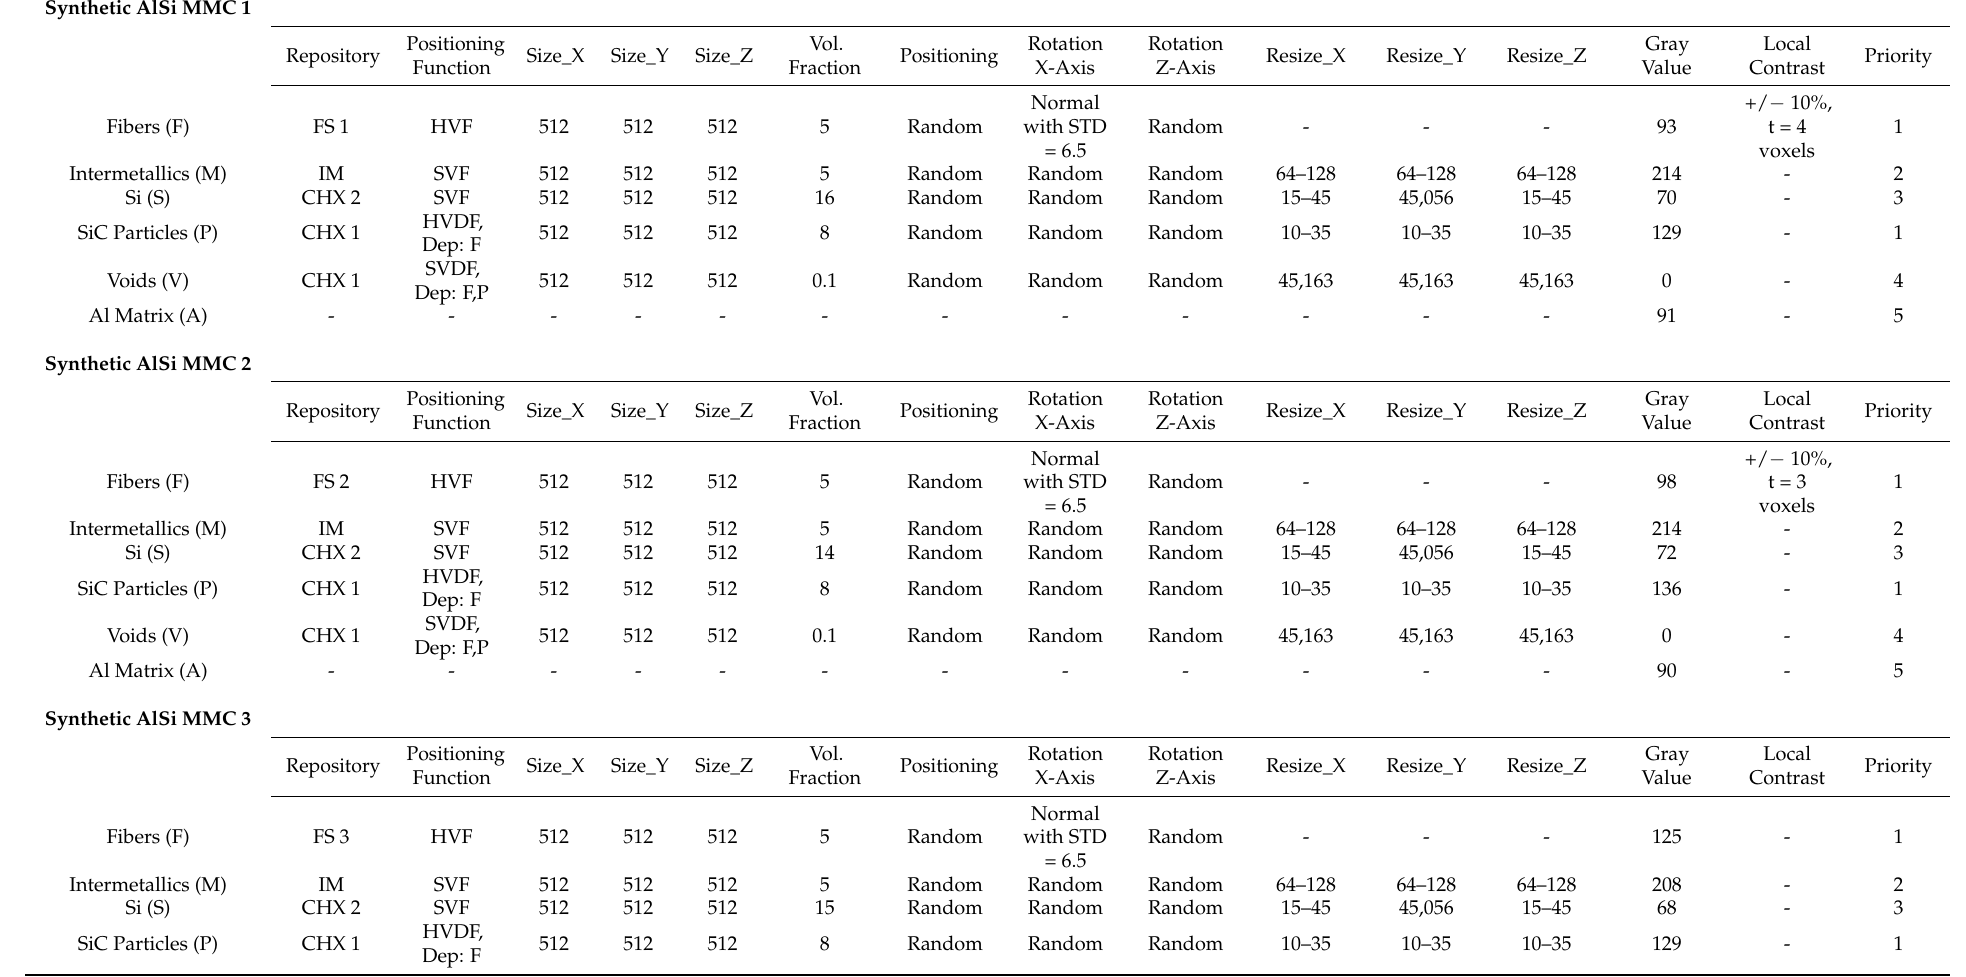
Table A1. Synthetic Al–Si MMCs 1–4